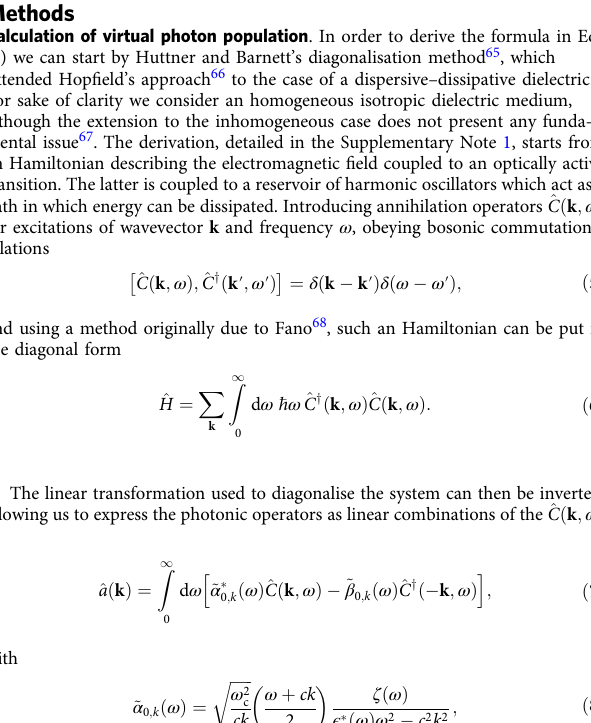
= 0.5 ω c 0 and different values of the losses. In both images